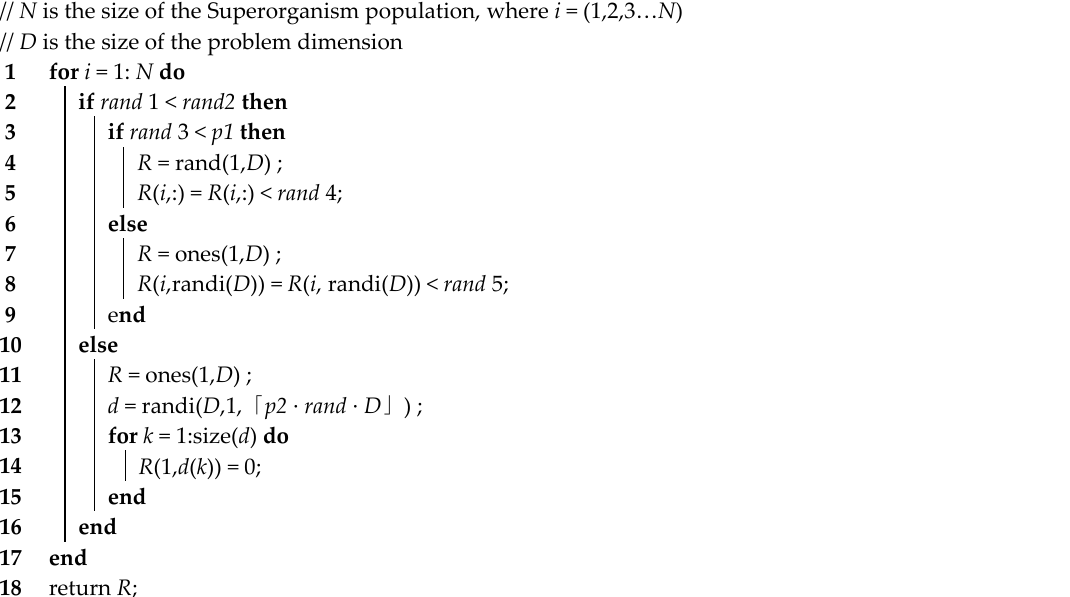
Mathematics 2020 , 8 , x FOR PEER REVIEW 8 of 21 matrix corresponds to the population size. If the value within the R matrix is greater than 0, the individual of the Superorganism is involved in the Stopover site. Algorithm 2. The random program is used to adjust the number of superorganisms in the search. // N is the size of the Superorganism population, where i = (1,2,3… N ) // D is the size of the problem